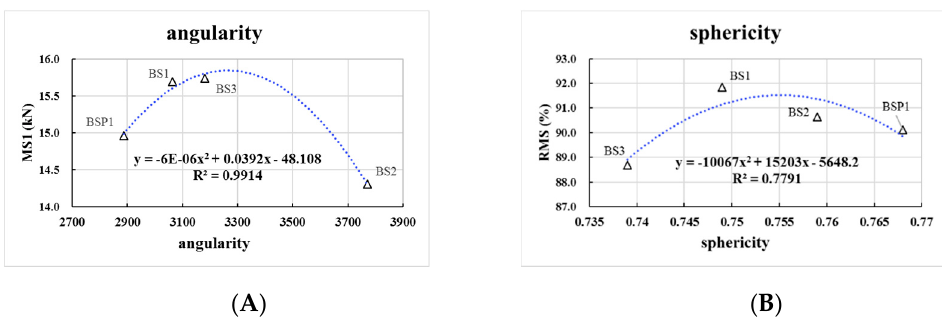
Figure 10. Correlation between Marshall stability test results and aggregate geometric characteristics. ( A ) correlation between MS1 and angularity; ( B ) correlation between RMS and sphericity.